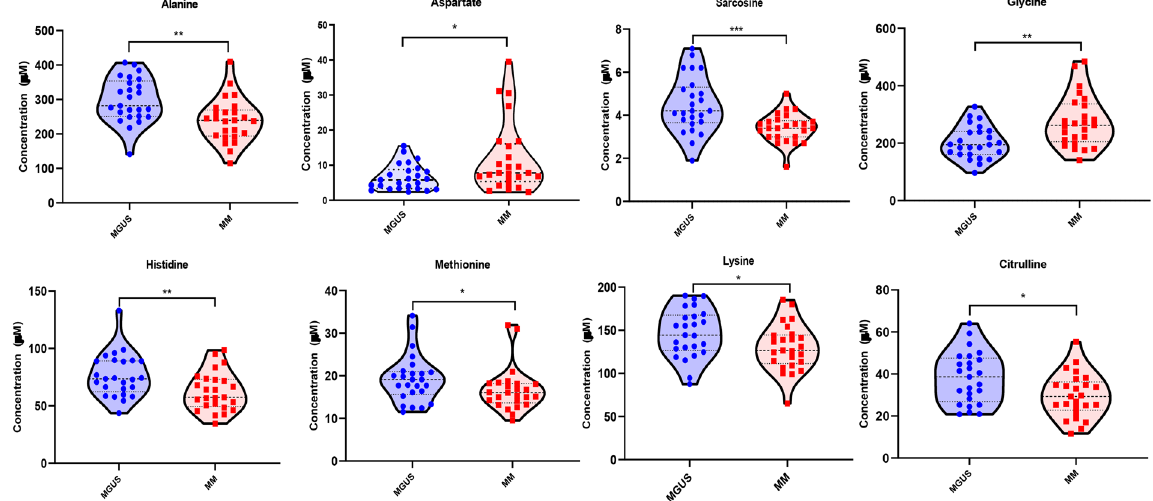
Figure 5. Violin plots comparing the median concentrations of various amino acids and metabolites in the bone marrow plasma between MGUS (N = 25) and MM (N = 25) groups. Data was analyzed by Mann-Whitney U test where *** p < 0.001, ** p < 0.01, * p < 0.05, # p < 0.1 but > 0.05, n.s.